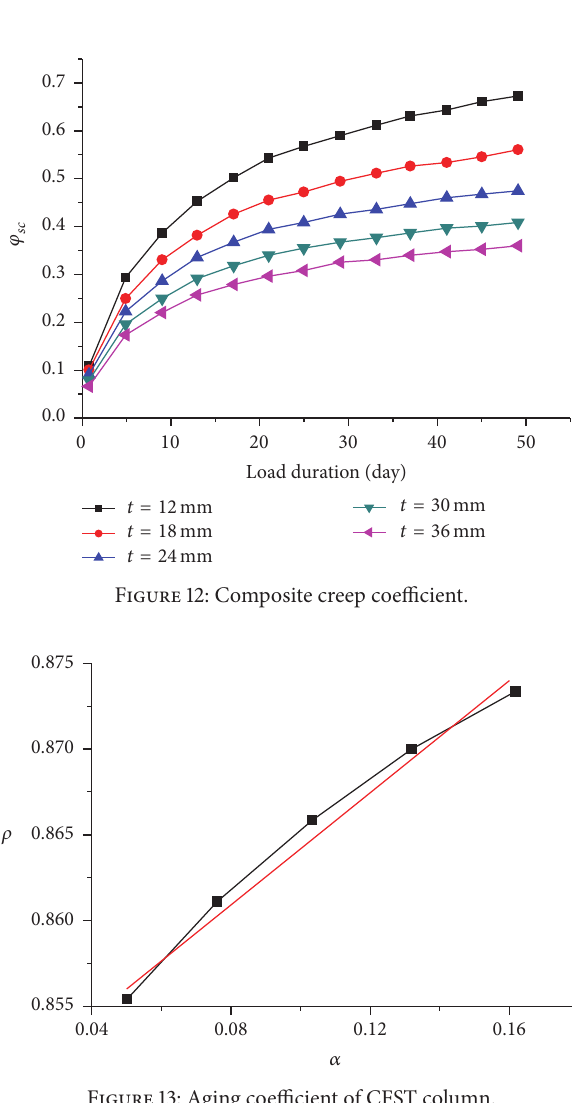
Figure 13: Aging coefficient of CFST column.